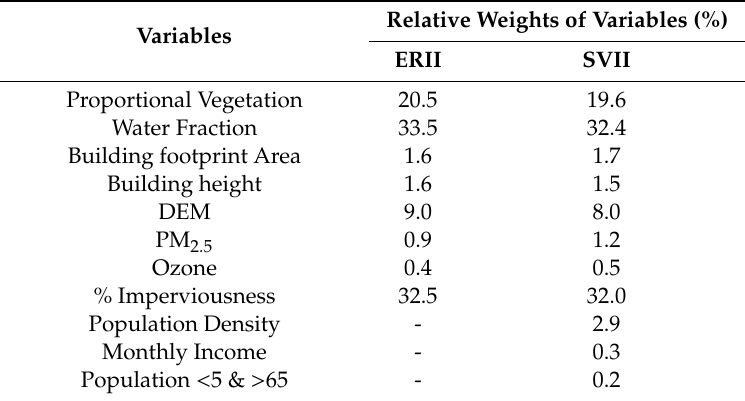
Table 2. ERII and SVII model parameters and summary results.